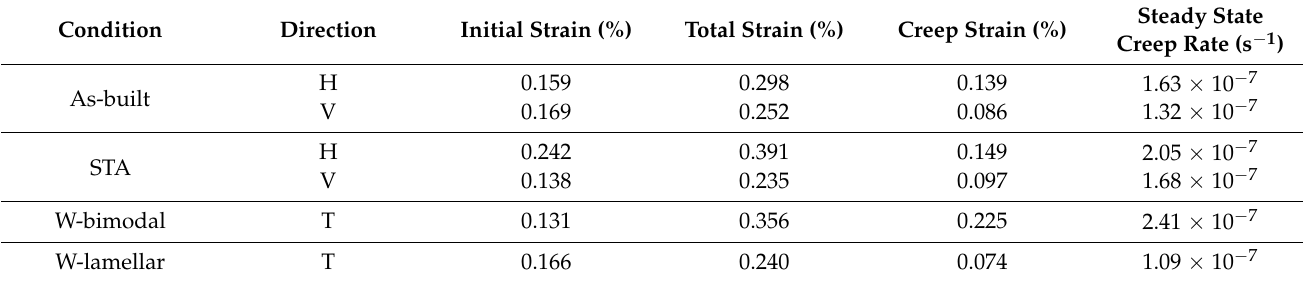
Table 5. Creep strain and steady state creep rate of the EB-DED and wrought Ti60